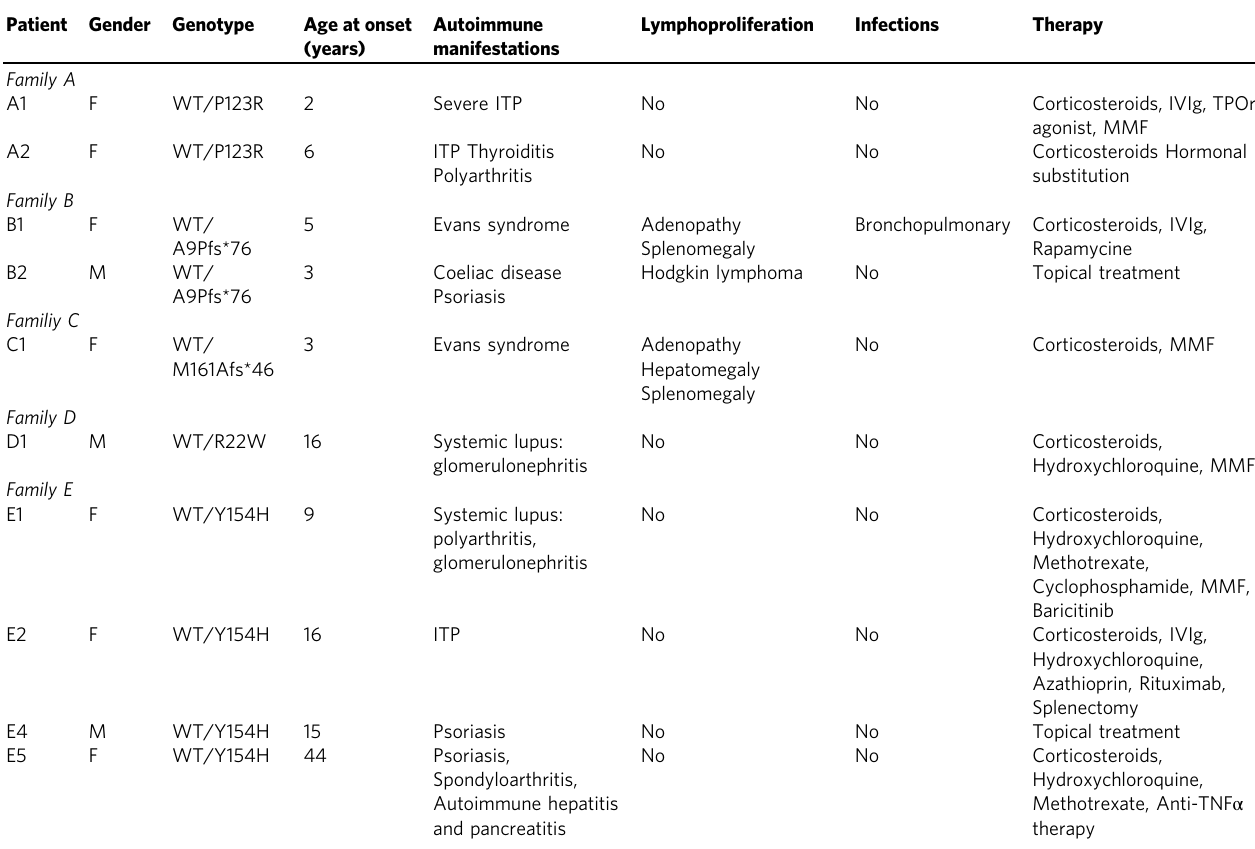
Table 1 Clinical phenotype of patients with SOCS1 mutations. Patient Gender